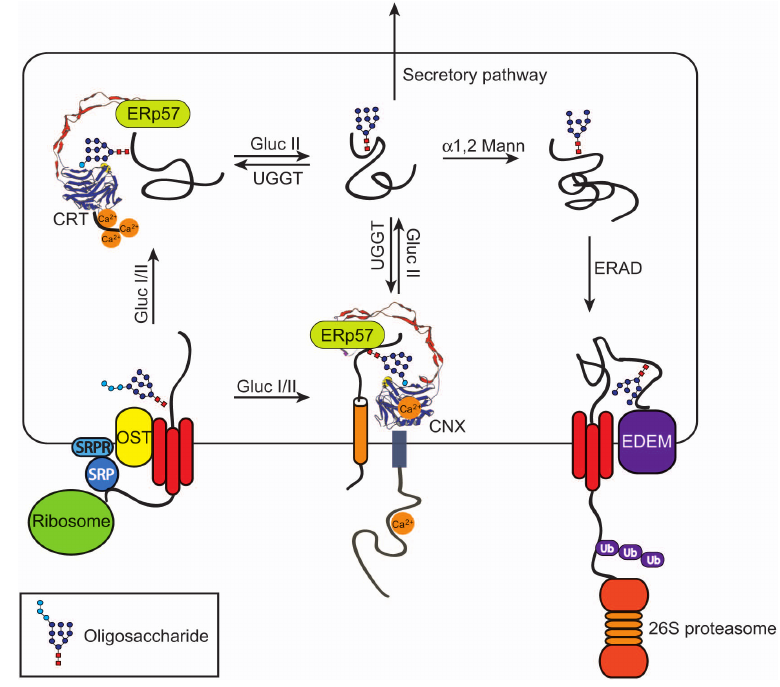
Figure 2 Quality control in the endoplasmic